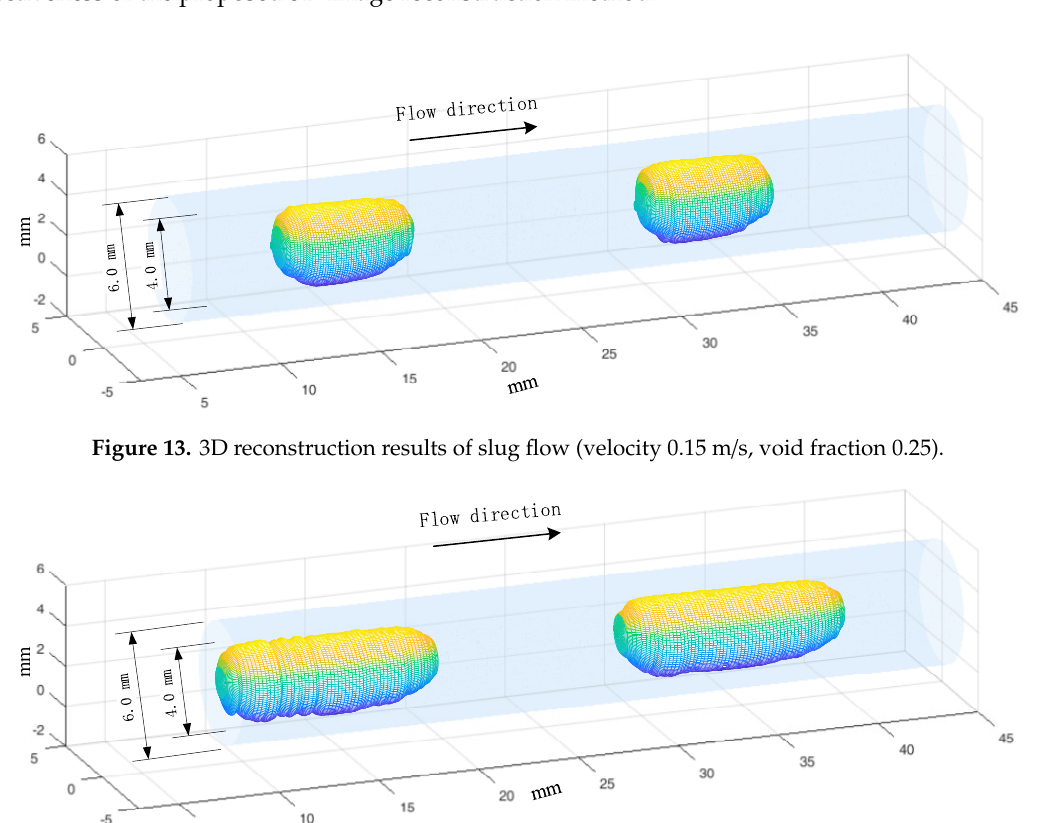
Figure 13. 3D reconstruction results of slug flow (velocity 0.15 m/s, void fraction 0.25).